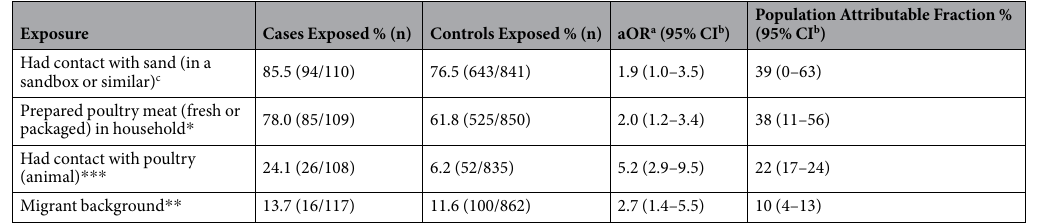
Table 4. Risk factors for Campylobacter infections in children < 5 years of age. Case-control study, Germany, 2011–2014. The proportion of exposed cases and controls is based on the number of cases and controls with complete answers in univariable analysis (without adjustment for age group, sex, federal state). Adjusted odds ratios (aOR) were determined in multivariable logistic regression analysis (adjusted for age group (0–2 years, 3–4 years), sex; federal state; 90 cases and 762 controls with complete answers for all variables in the final model). No factors were negatively associated with disease in the final model. a Adjusted odds ratio. b Confidence